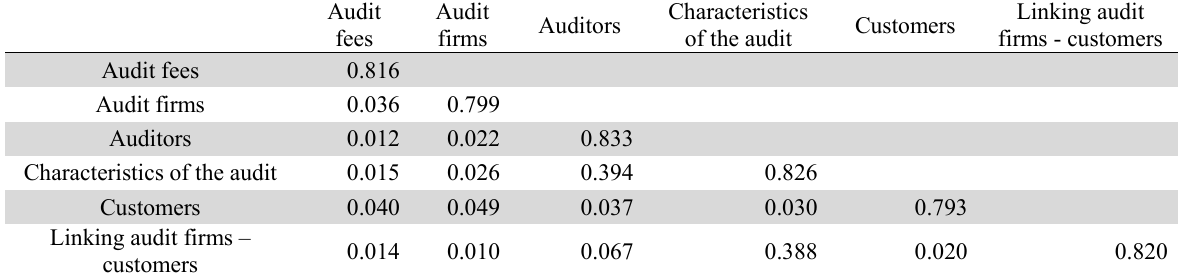
Discriminant Validity Fornell-Larcker Criterion